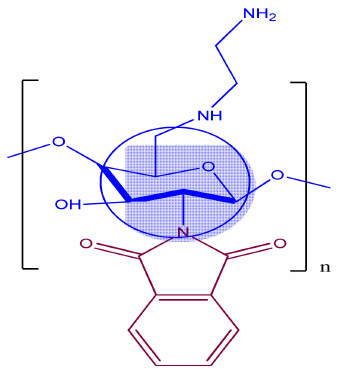
Figure 1. Antiviral activity (Newcastle virus) of chitosan derivatives.